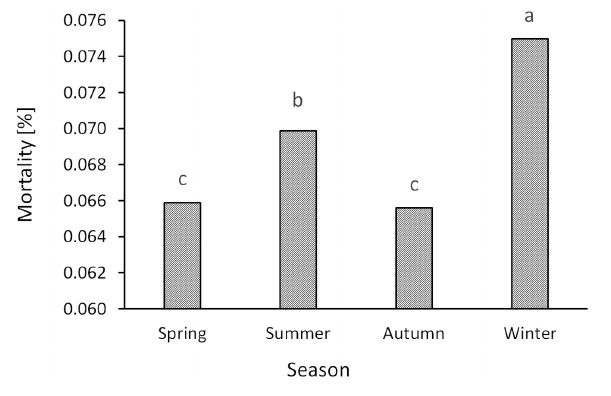
Figure 2. Transport-related mortality of finisher pigs as affected by the season of the year. a,b,c Mortality in columns with different superscripts differ significantly